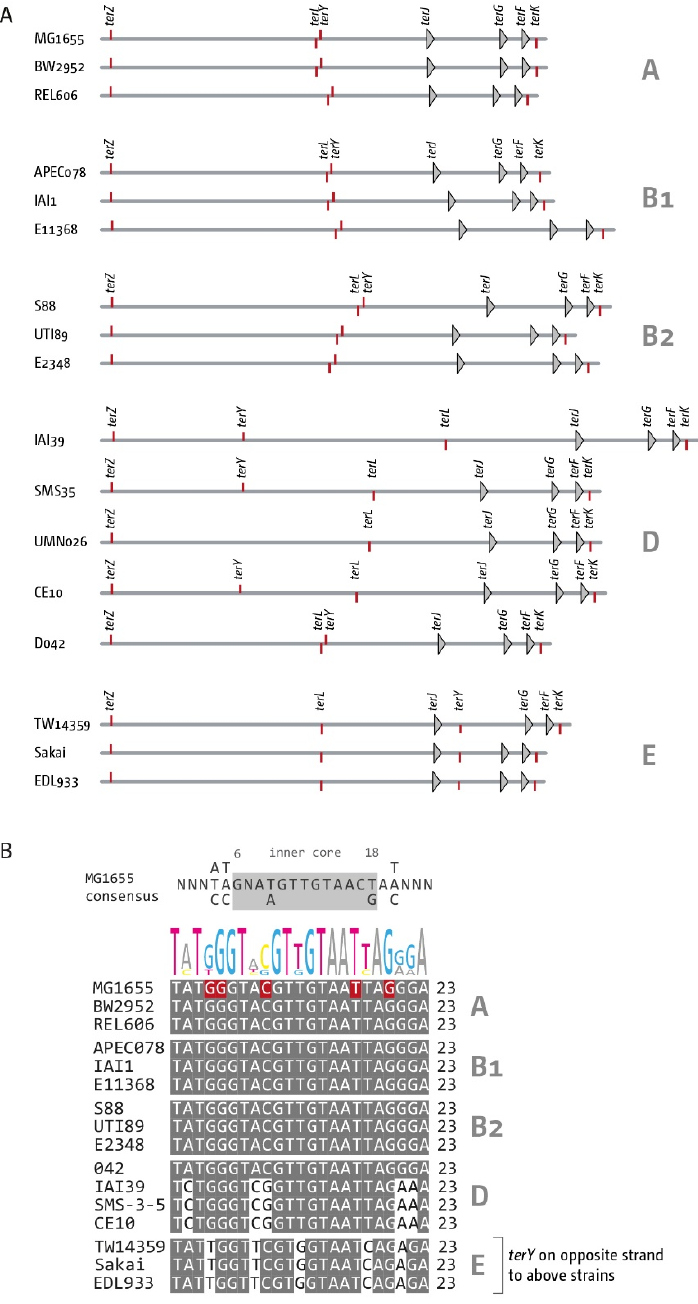
Figure 5. Distribution and sequence comparison of the secondary ter sites K , L , Y and Z in E. coli . ( A ) Location and distribution of the secondary ter sites K , L , Y and Z in phylogroups A, B1, B2, D and E. Genomes from the same phylogroups are clustered, with the group indicated on the right-hand side, and for groups A, B1, B2 and D, labels are only shown at the top. For phylogroup D, labels are shown for each genome because of the higher variability. Primary ter sites F , G and J are shown for orientation purposes (compare with Figure 1A). All primary ter sites are identified by triangles. Because some of the secondary ter sites are very close to each other, secondary ter sites are shown by a red tick mark. If the tick mark is below the genome line forks approaching from the left will encounter ter /Tus complexes in the permissive orientation. If the tick mark is above the genome line, then forks approaching from the left will encounter ter /Tus complexes in the restrictive orien- tation. ( B ) Sequence comparison of all terY sites from all strains across all 5 phylogroups in compar- ison to the sequence found MG1655 sequences. The ter consensus sequence derived from MG1655 is shown at the top. In MG1655, 5 base pairs of terY differ to the ter consensus sequence, 2 of which are situated in the inner core sequence, which explains the low fork block activity observed [15].